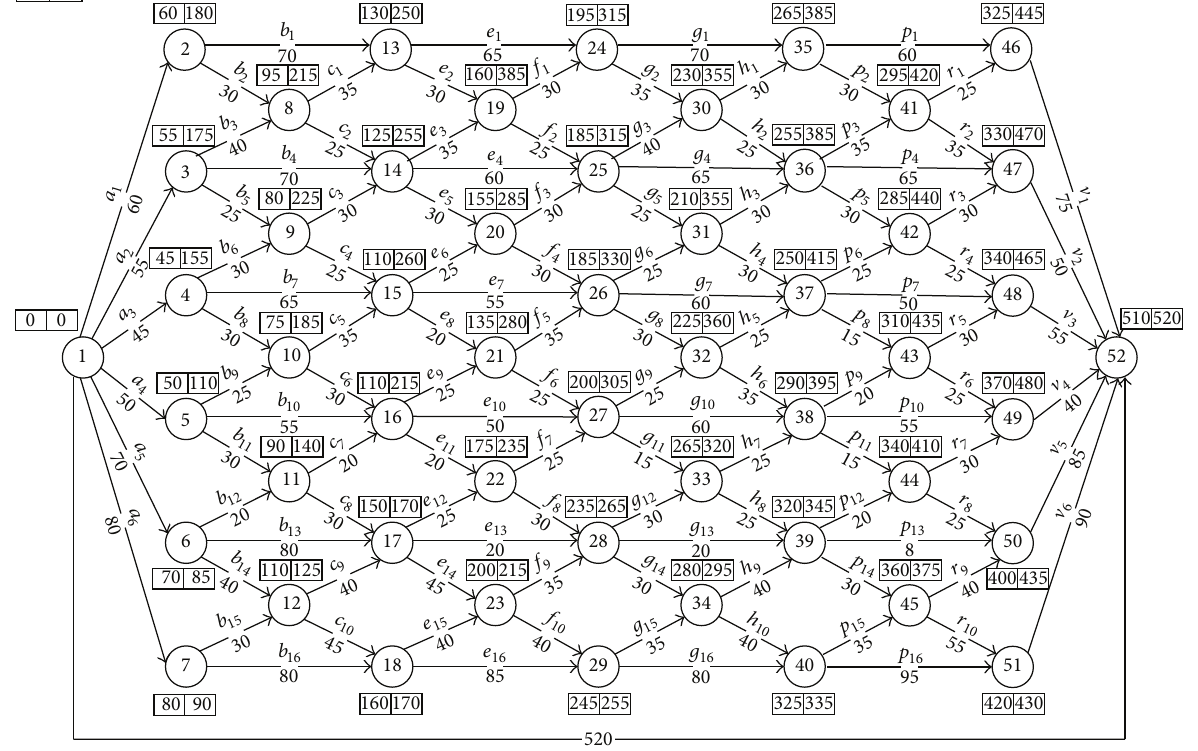
Figure 1: Time parameters for all activities with their shortest durations.